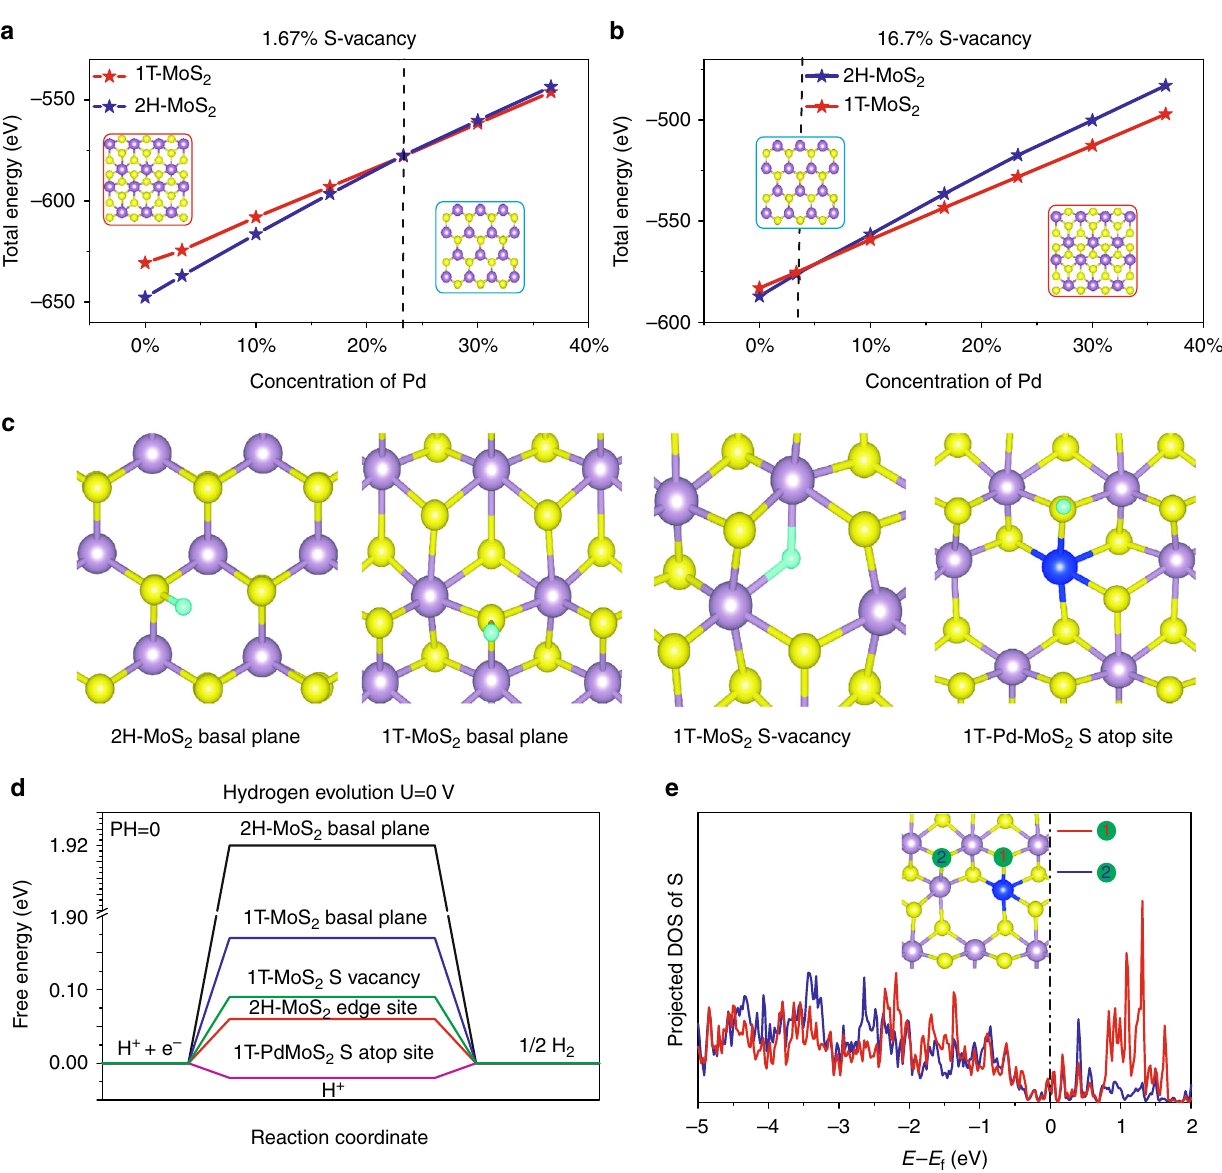
Fig. 4 DFT calculation for the energetics of Pd doping to promote the HER activity of MoS 2 variation in the energy of 2H – MoS 2 and 1T – MoS 2 as the concentration of Pd changes at SV concentrations of a 1.67% and b 16.7%. c Adsorption positions for a single H atom absorbing on pure MoS 2 and Pd – MoS 2 . d Free energy versus the reaction coordinates of different active sites. e Projected p-orbital density of states of S. Site 1 indicates S atop site adjacent to the Pd atoms in the 1T MoS 2 ; site 2 indicates the in-plane S of the 1T basal